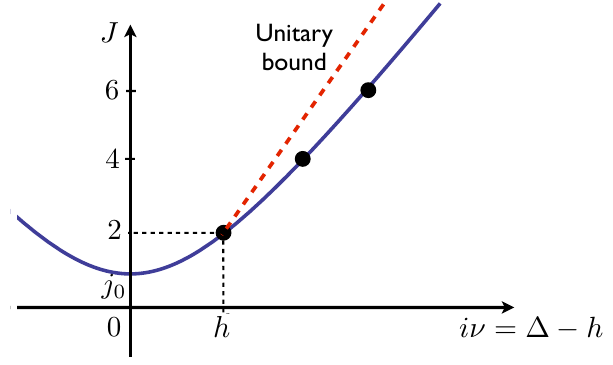
Figure 1 . Shape of the leading Regge trajectory J = j ( (cid:23) ) with vacuum quantum numbers in a CFT. The dimension of operators (cid:1) is related to the spectral parameter (cid:23) by (cid:1) = h + i(cid:23) where h = d= 2. The function j ( (cid:23) ) is even and convex. The minimum (for imaginary (cid:23) ) is the intercept j (0)